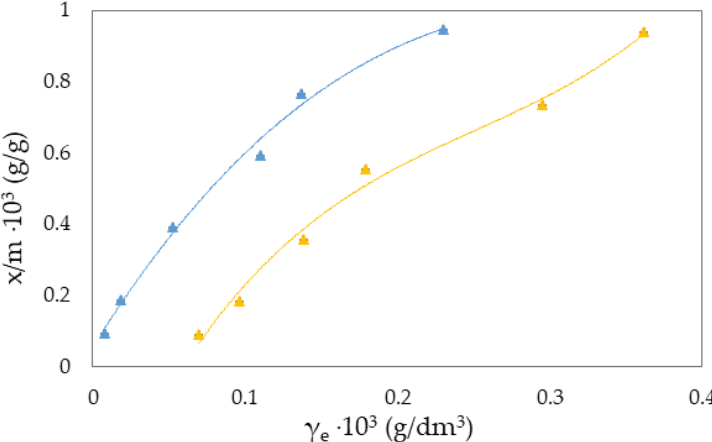
Figure 3. Freundlich adsorption isotherm curves for the suspension RB-NaY at ▲ 283 K and ▲ 293 K.